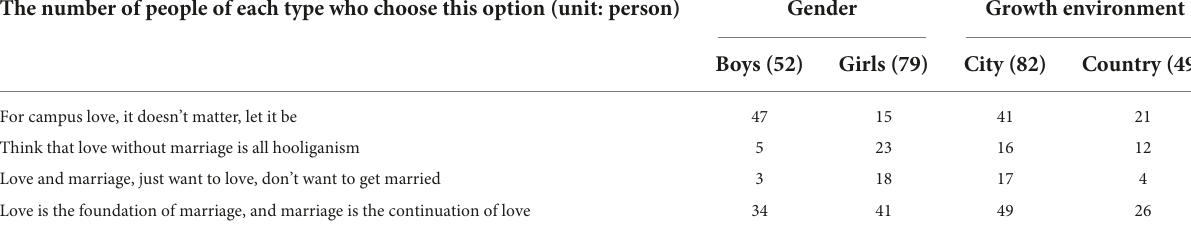
TABLE 11 Intra group comparative data on the independence of college students from divorced families. The number of people of each type who choose this option (unit: person)